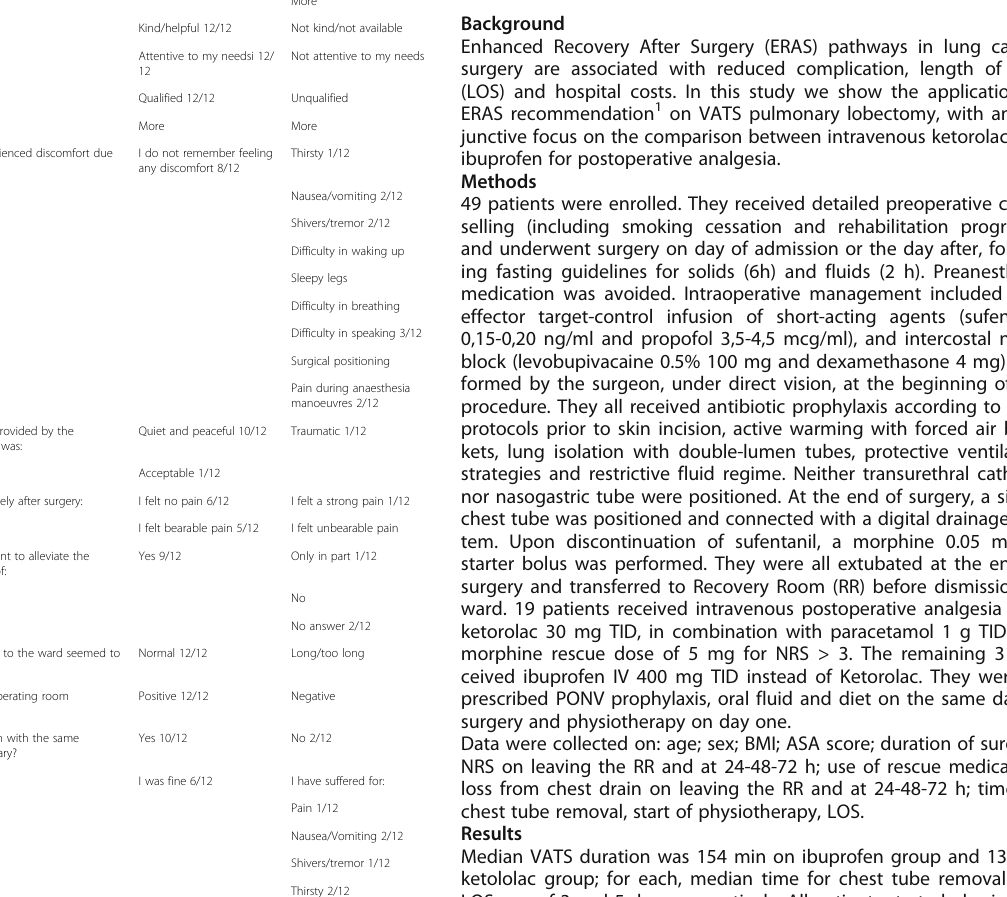
Correspondence: Scardua J. J Anesth Analg Crit Care 2022, 2(Suppl 1): 71.